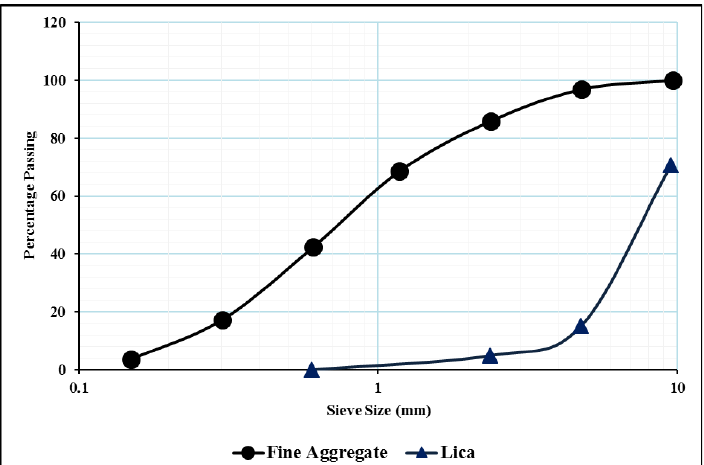
Figure 1 . The grain size distribution curve of fine and light weight aggregates